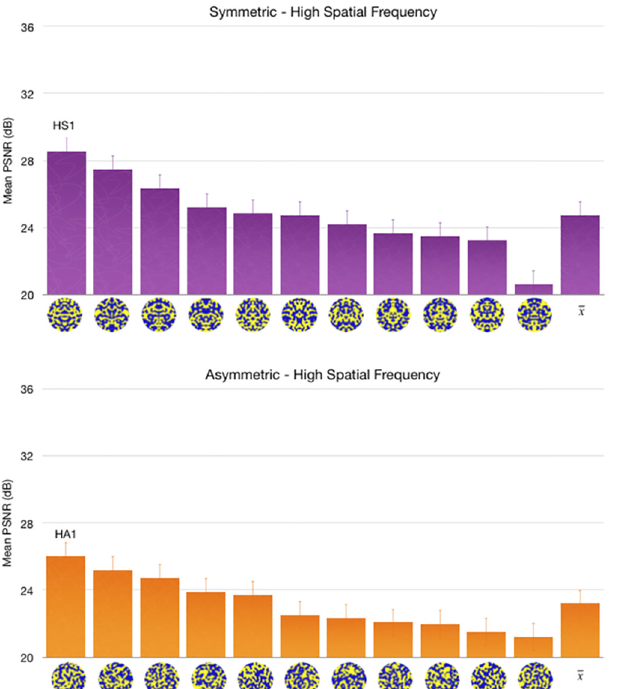
Fig 5. PSNR reconstruction values for high-spatial frequency symmetric and asymmetric patterns. Error bars show 95% confidence interval. The patterns labelled “ HS1 ” and “ HA1 ” were selected for a behavioural experiment testing the predictions of this model. The figure shows test patterns in their original form, as used in the behavioural experiment.